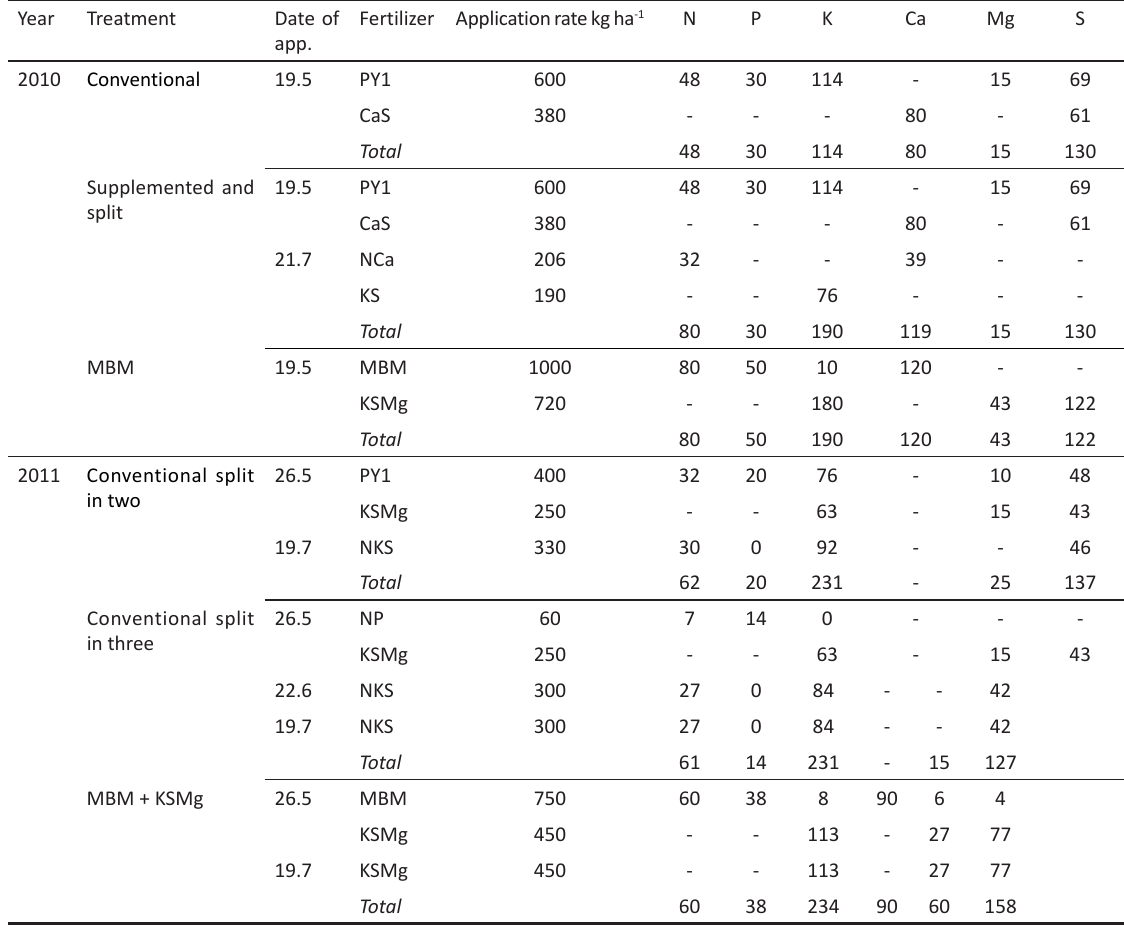
Table 8. Rates of fertilizer applications (kg ha -1 ) and mineral nutrients applied for the carrot in 2010 and 2011 trials Year